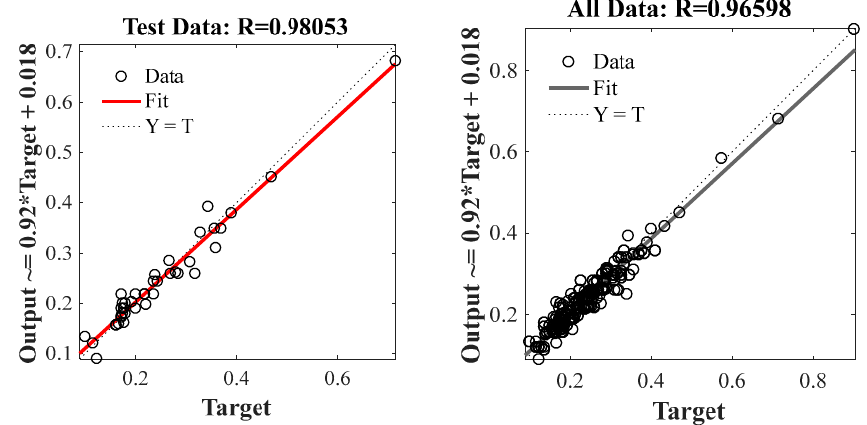
Figure 8. Regressions of training, validating, and testing datasets simulated by ANN 6:15:1.